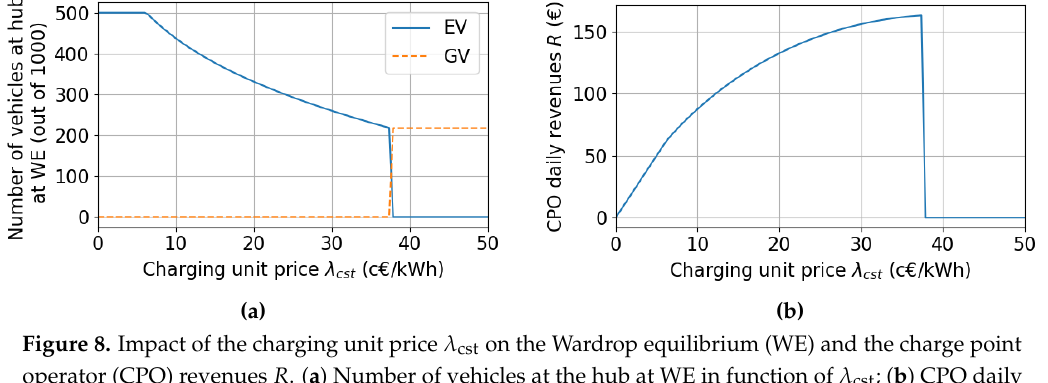
Figure 8. Impact of the charging unit price λ cst on the Wardrop equilibrium (WE) and the charge point operator (CPO) revenues R . ( a ) Number of vehicles at the hub at WE in function of λ cst ; ( b ) CPO daily revenues R in function of λ cst . As λ cst increases, fewer EV choose the hub while R increases, up to a threshold λ ∗ cst = 37.5 c e /kWh beyond which all EV drive downtown.